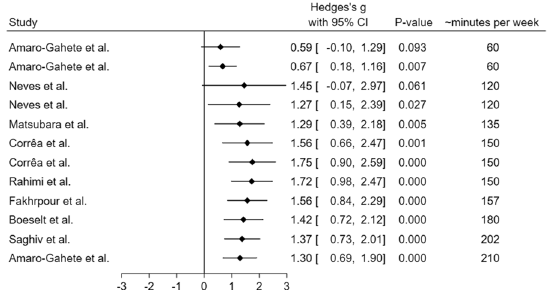
Figure 5. Cumulative forest plot from a random-effect meta-analysis shown as Hedges’ g with 95% CIs of the increase of minutes per week on Klotho concentrations. For each study, the square represents the Hedges’ g of the intervention effect with the horizontal line intersecting it as the lower and upper limits of the 95%